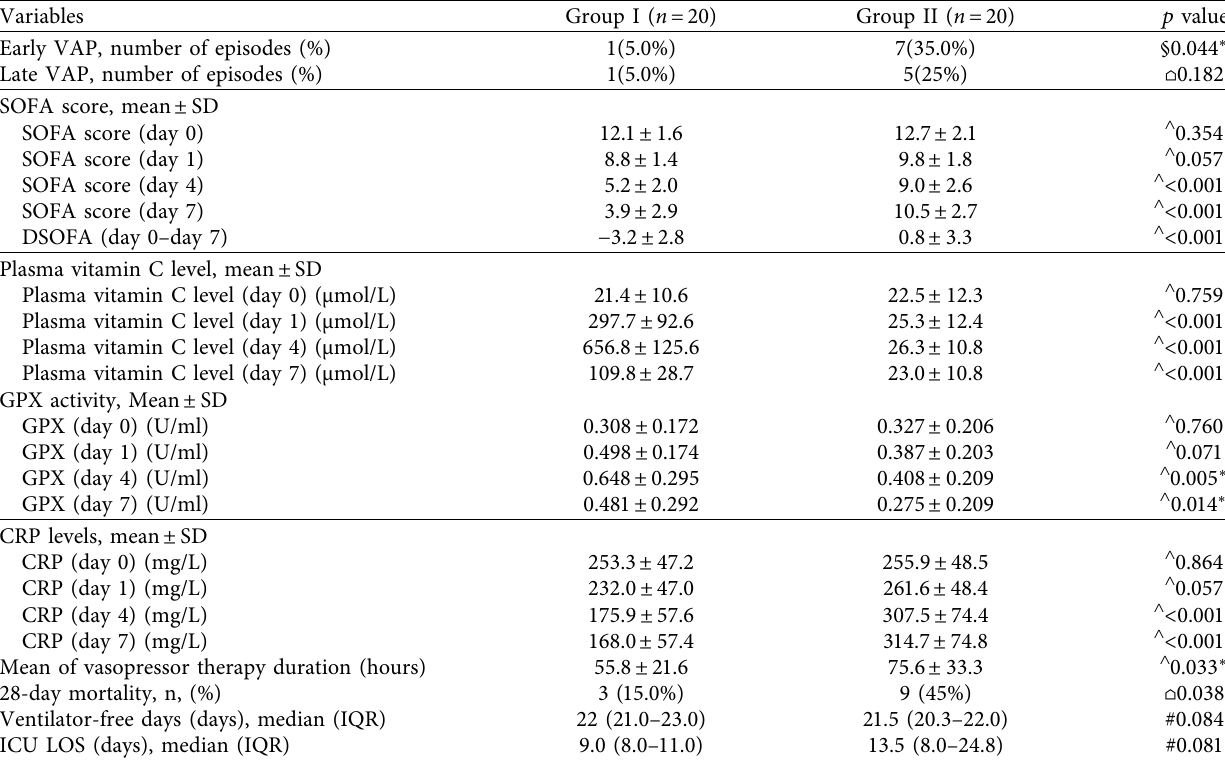
Table 3: Clinical outcomes between the study